Question: Which visualization type does this figure use?
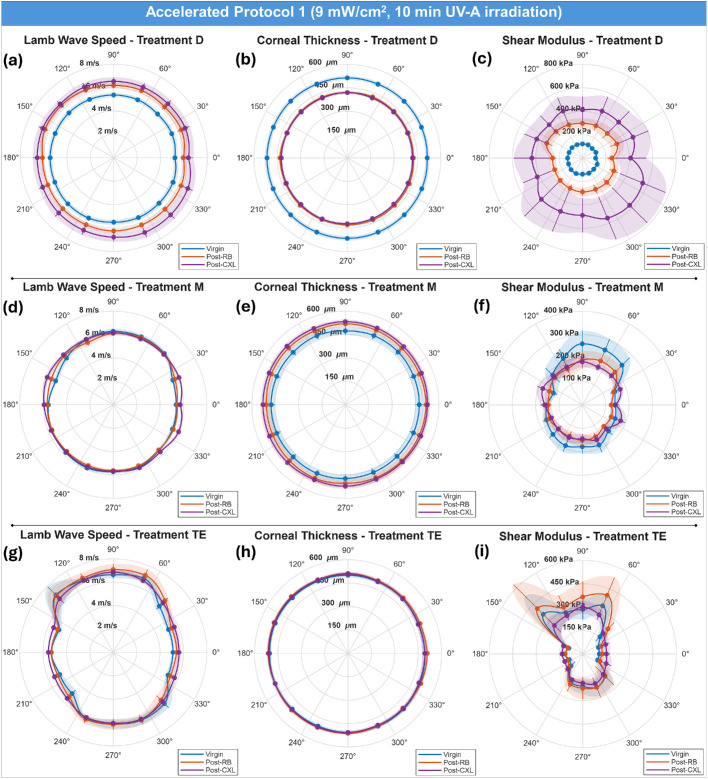
Answer: scatter